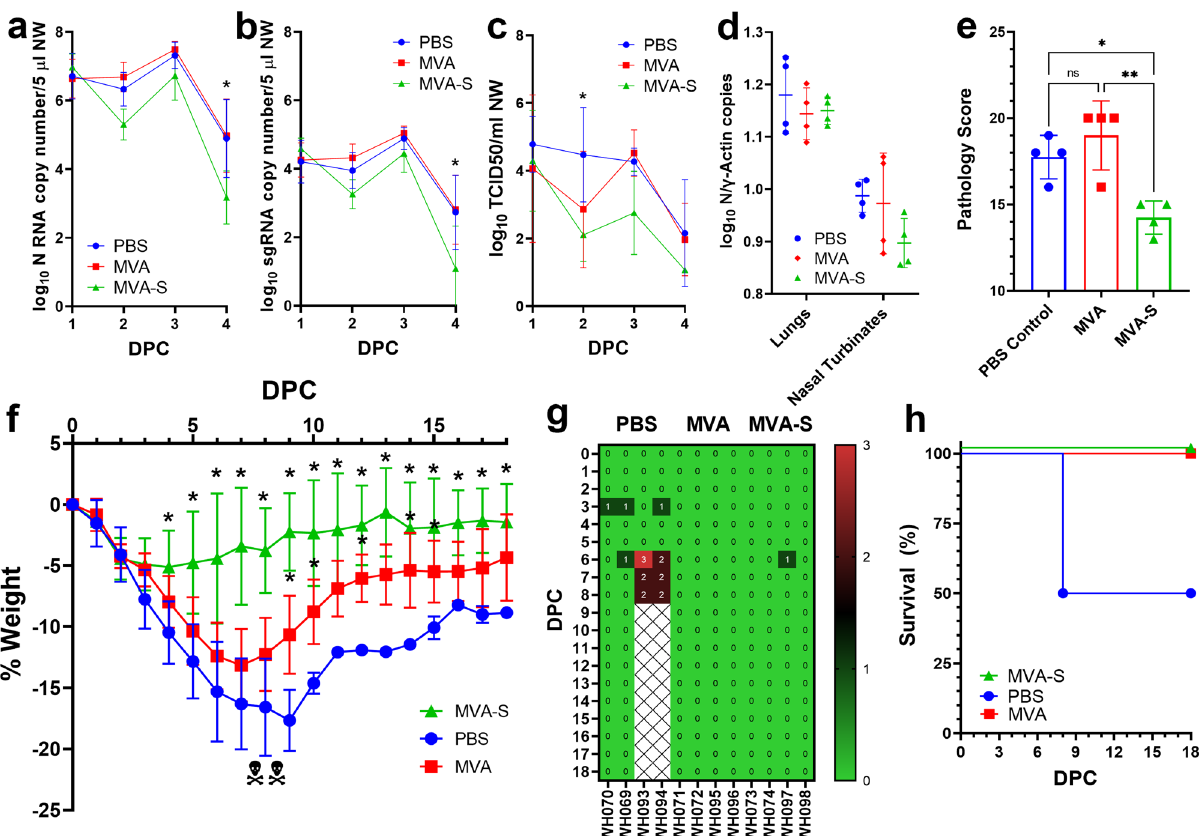
Fig. 4 Ef fi cacy of MVA-S vaccination in Syrian hamsters. Vaccinated and boosted adult Syrian hamsters ( n = 4 per group) were challenged with 10 5 TCID50 SARS-CoV-2 WA1/2020 in two experiments. In the fi rst experiment, nasal washes were collected on days 1 – 4 post challenge (DPC) and titrated for total RNA ( a ), subgenomic RNA ( b ), and infectious virus titers by TCID50 assay ( c ). At 4 DPC, total viral RNA from lungs and nasal turbinates was quanti fi ed compared to γ -actin controls ( d ) and pathology in infected lungs compared by scoring ( e ). In a separate experiment, hamsters were vaccinated, boosted, and weighed daily for 18 days post challenge ( f ) with daily checks for morbidity ( g ) and mortality ( h ). Clinical scores ( g ) were assigned based on the following metric: 0 — Normal; 1 — Ruf fl ed Fur; 1 — Labored Breathing; 1 — Lethargy; 1 — Conjunctivitis. On day 8, two animals from the PBS control group met humane early endpoints, were euthanized, and removed from the study ( ). * P < 0.1, ** p < 0.01, and n.s. not signi fi cant. Standard deviations are shown by error